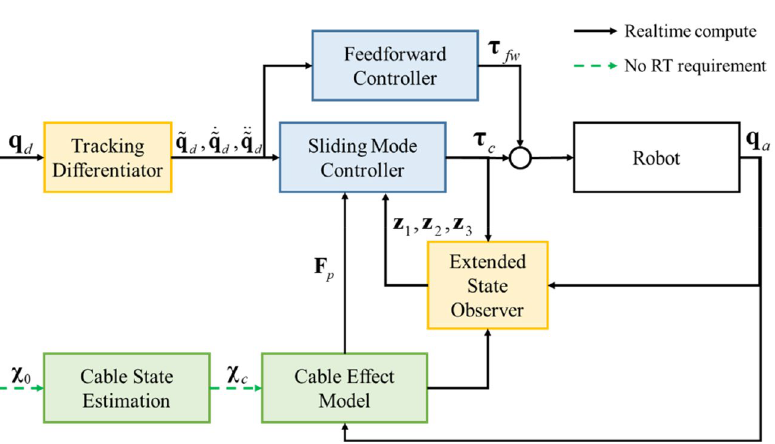
Figure 10. Control structure of the cable model based DRSMC framework. q d is the given trajectories of ˙ ∼ ¨ ∼ ∼ , , q q q desired positions; d d d are the actual reference trajectories generated using the tracking differentiator; , ˙ q q a a are the joint angles and joint velocities of robot, respectively; generated using the extended state observer 25 ; τ c is the feedback control torque; τ fw is the feedforward control torque; χ 0 is the measurement states of the cable and χ c is the generated cable representation for the cable effect